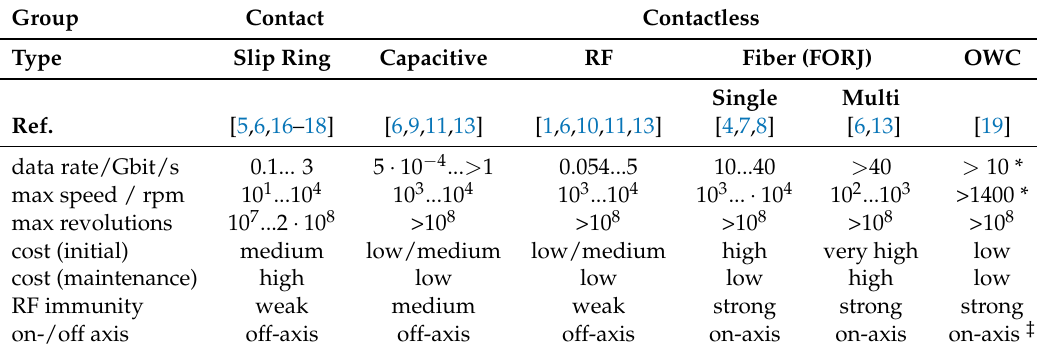
Table 1. Common principles for rotary data transmission and their typical state-of-the-art performance. Values should be understood as orders of magnitude rather than exact values. * Higher values are possible but have not been published yet; ‡ this work is limited to on-axis